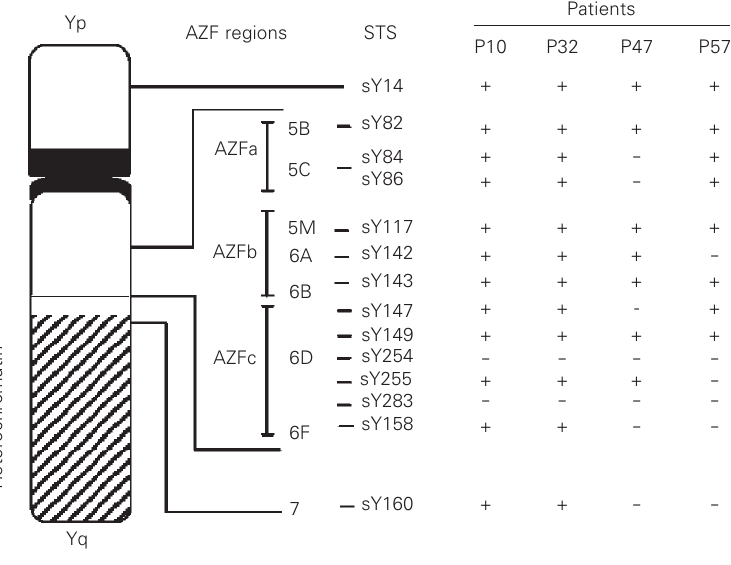
Figure 1. Schematic diagram of the human Y chromosome, including AZF regions (AZFa, AZFb and AZFc) and deletion intervals 5, 6 and 7, as defined by Vogt et al. (6). The list of sequence-tagged sites (STS) screened by PCR and their localization along the Y chromo- some is shown. The presence (+) or absence (-) of STS amplification, observed in patients P10, P32, P47 and P57, is also